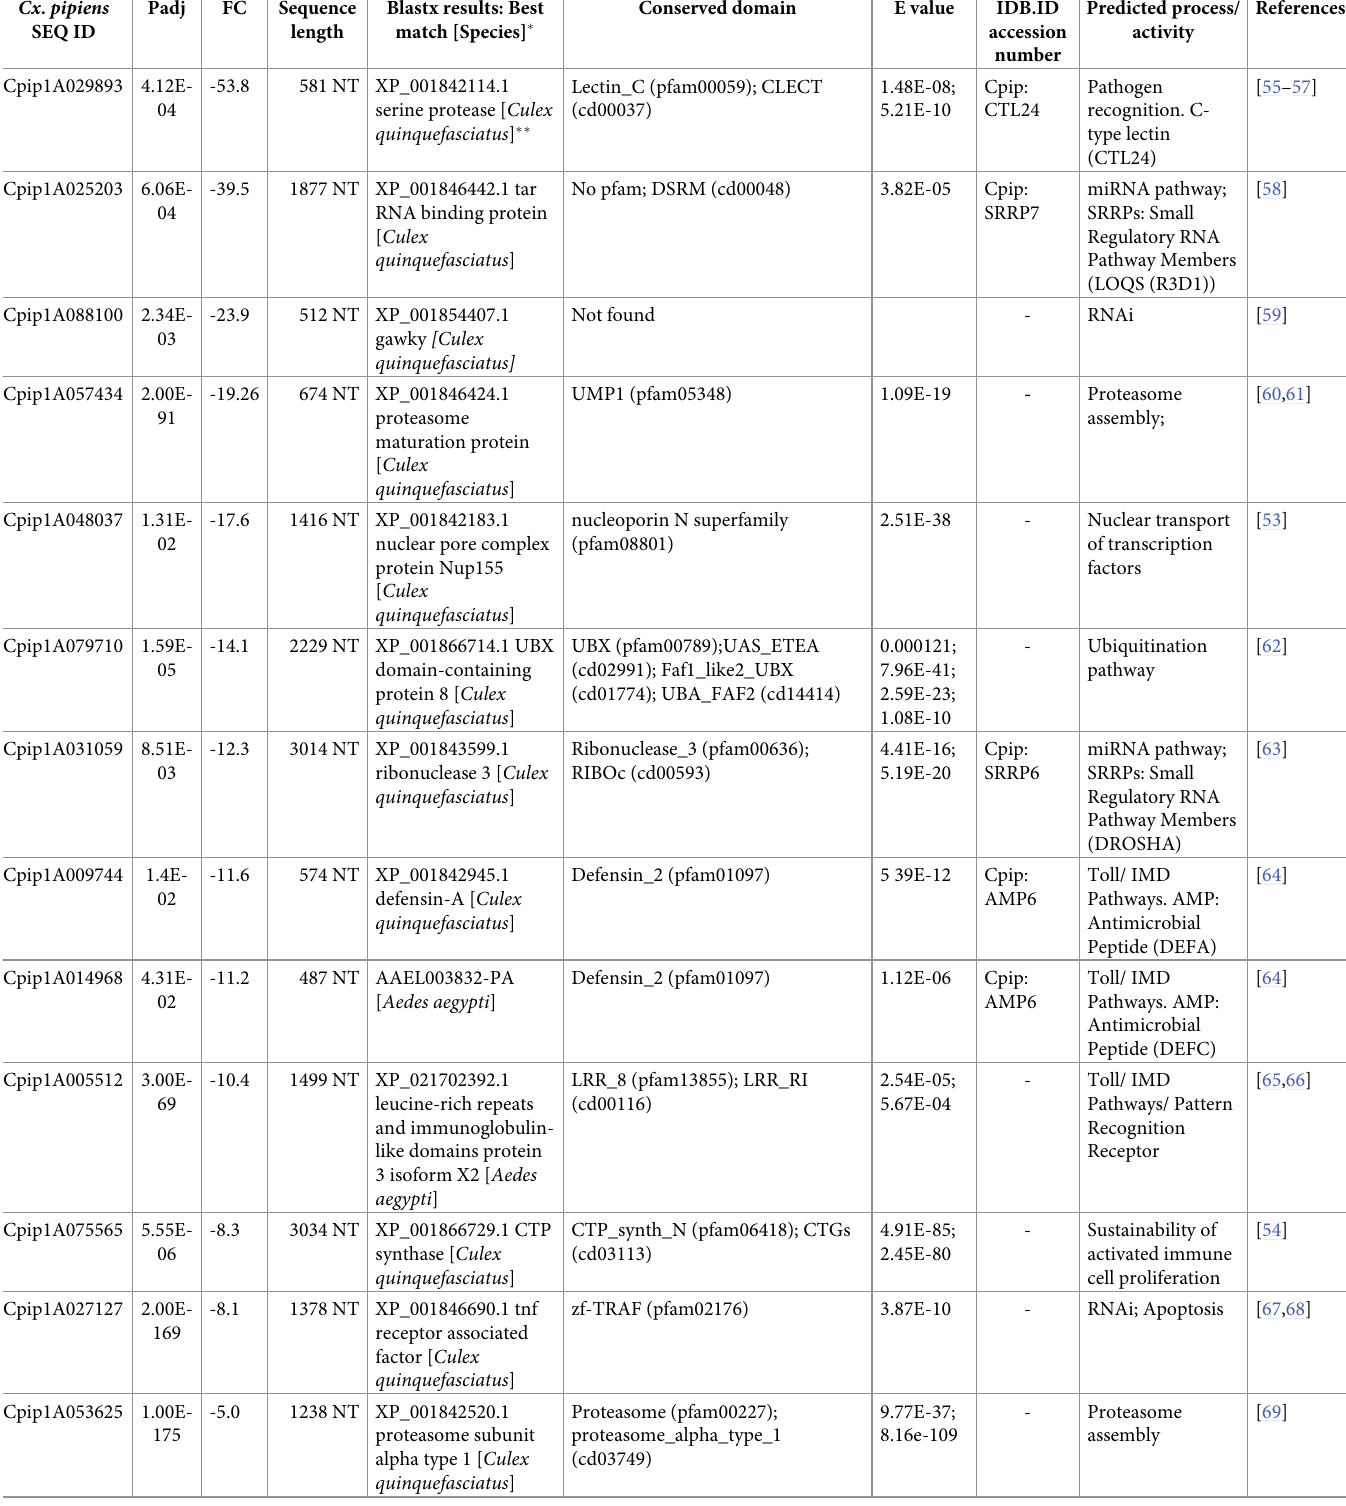
Table 2. DEG related to the immune infection-defense response at 2